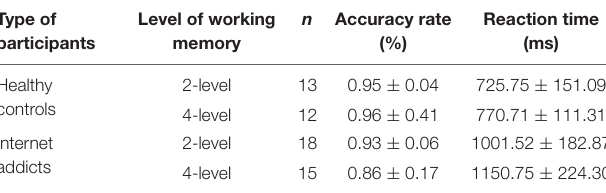
TABLE 3 | Descriptive statistics for accuracy rates and reaction times according to participant type and level of difficulty in working memory ( M ± SD